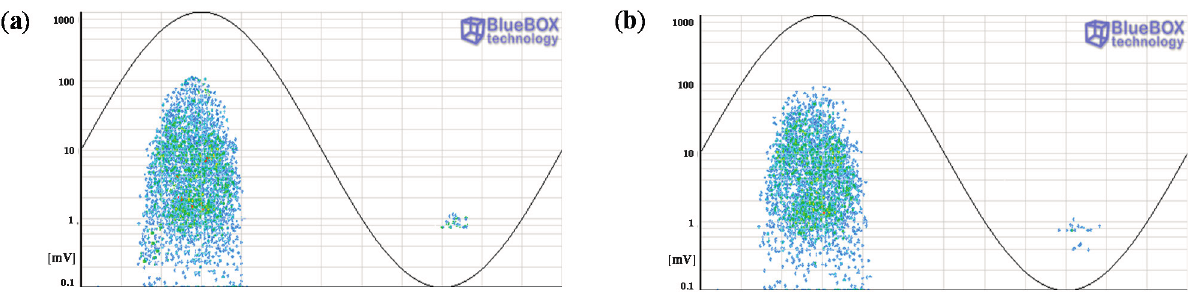
Figure 27. PRPD patterns obtained with the UHF sensors. ( a ) Sensor UHF 1 in position A; ( b ) Sensor UHF 2 in position